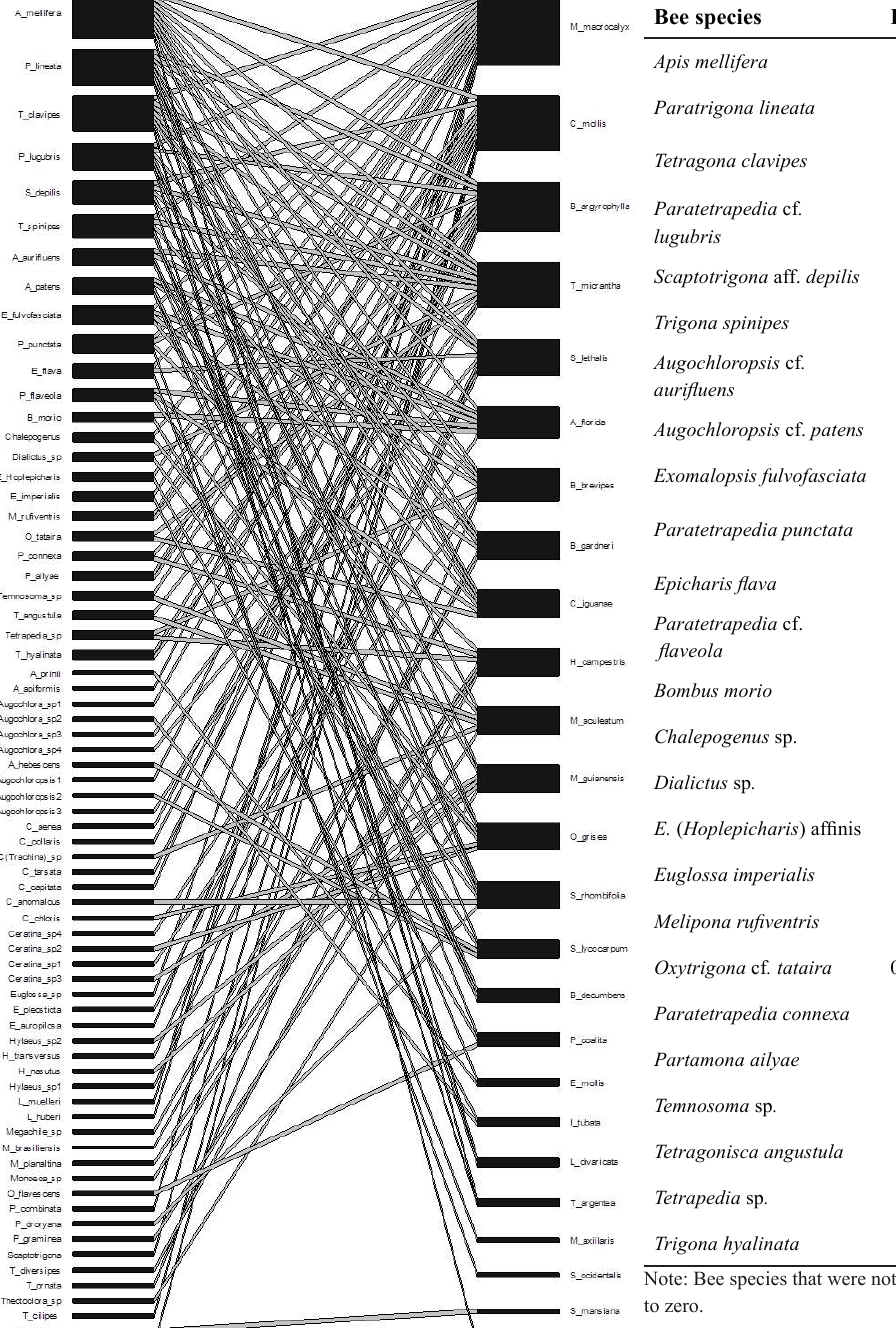
Fig 2 . Bipartite graph of bee-plant interaction’s network sampled in the Semideciduous Forest of “Fazenda São José”, Uberlândia-MG, in 2010 and 2011. Bees are represented on the left side of the graph and plants on the right side.